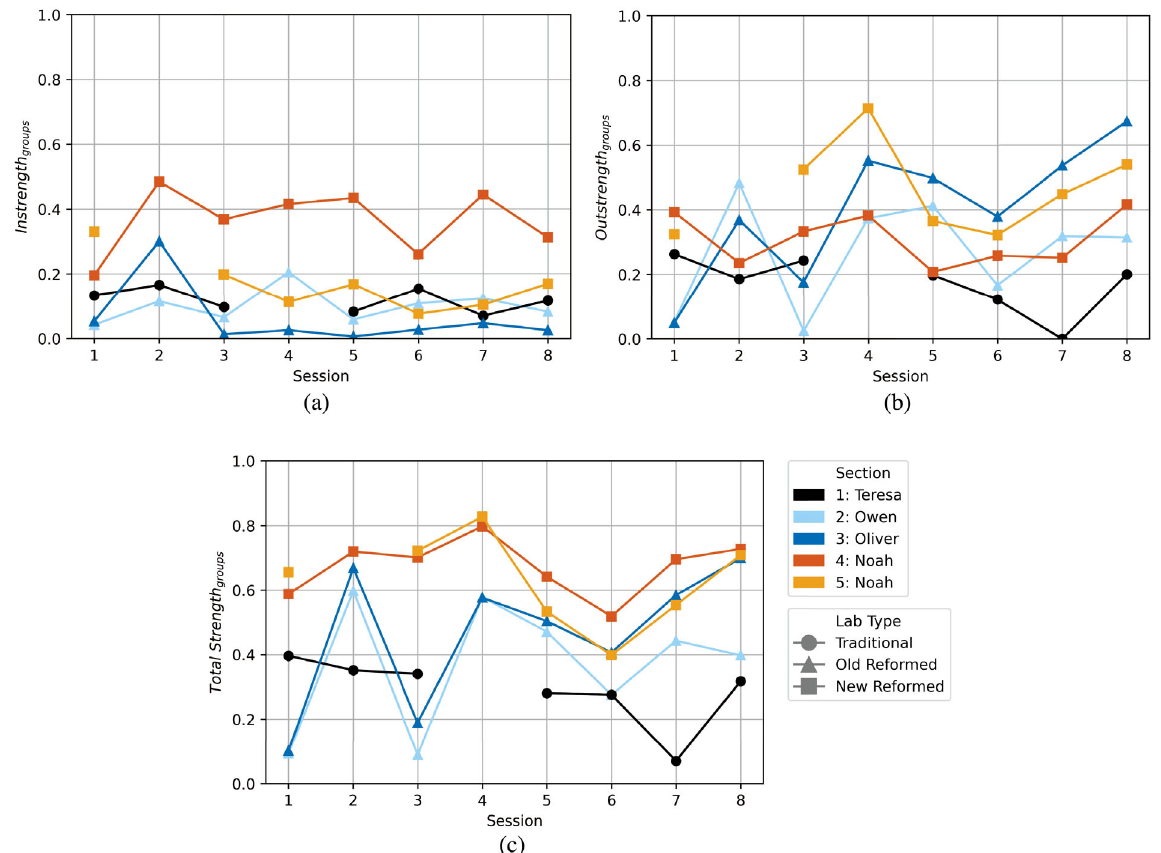
FIG. 2. Strength measures for interactions between the instructor and each individual group normalized by the duration of the lab session. Missing data points correspond to uncodable lab sessions. Instrength outstrength includes only instructor-initiated interactions, and total strength group for all codable sessions. (c) Total strength codable sessions. (b) Outstrength group